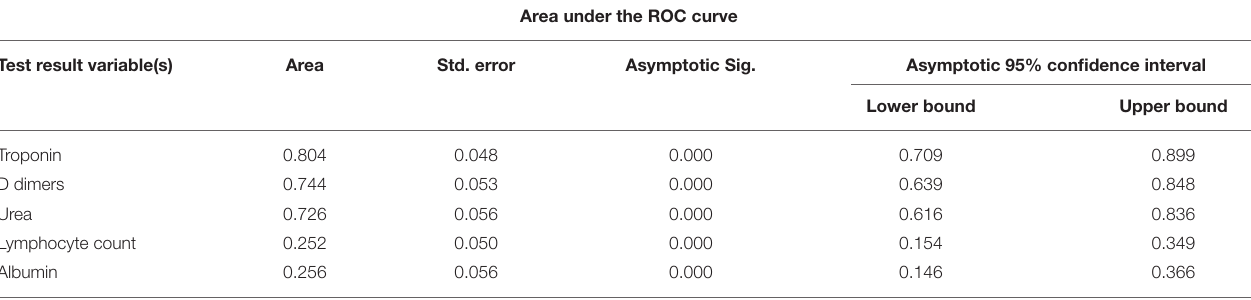
TABLE 7 | Probabilistic forecasts for binary classification (ICU vs. NO ICU) predictive modeling using ROC Curves and Precision-Recall curves. Area under the ROC curve